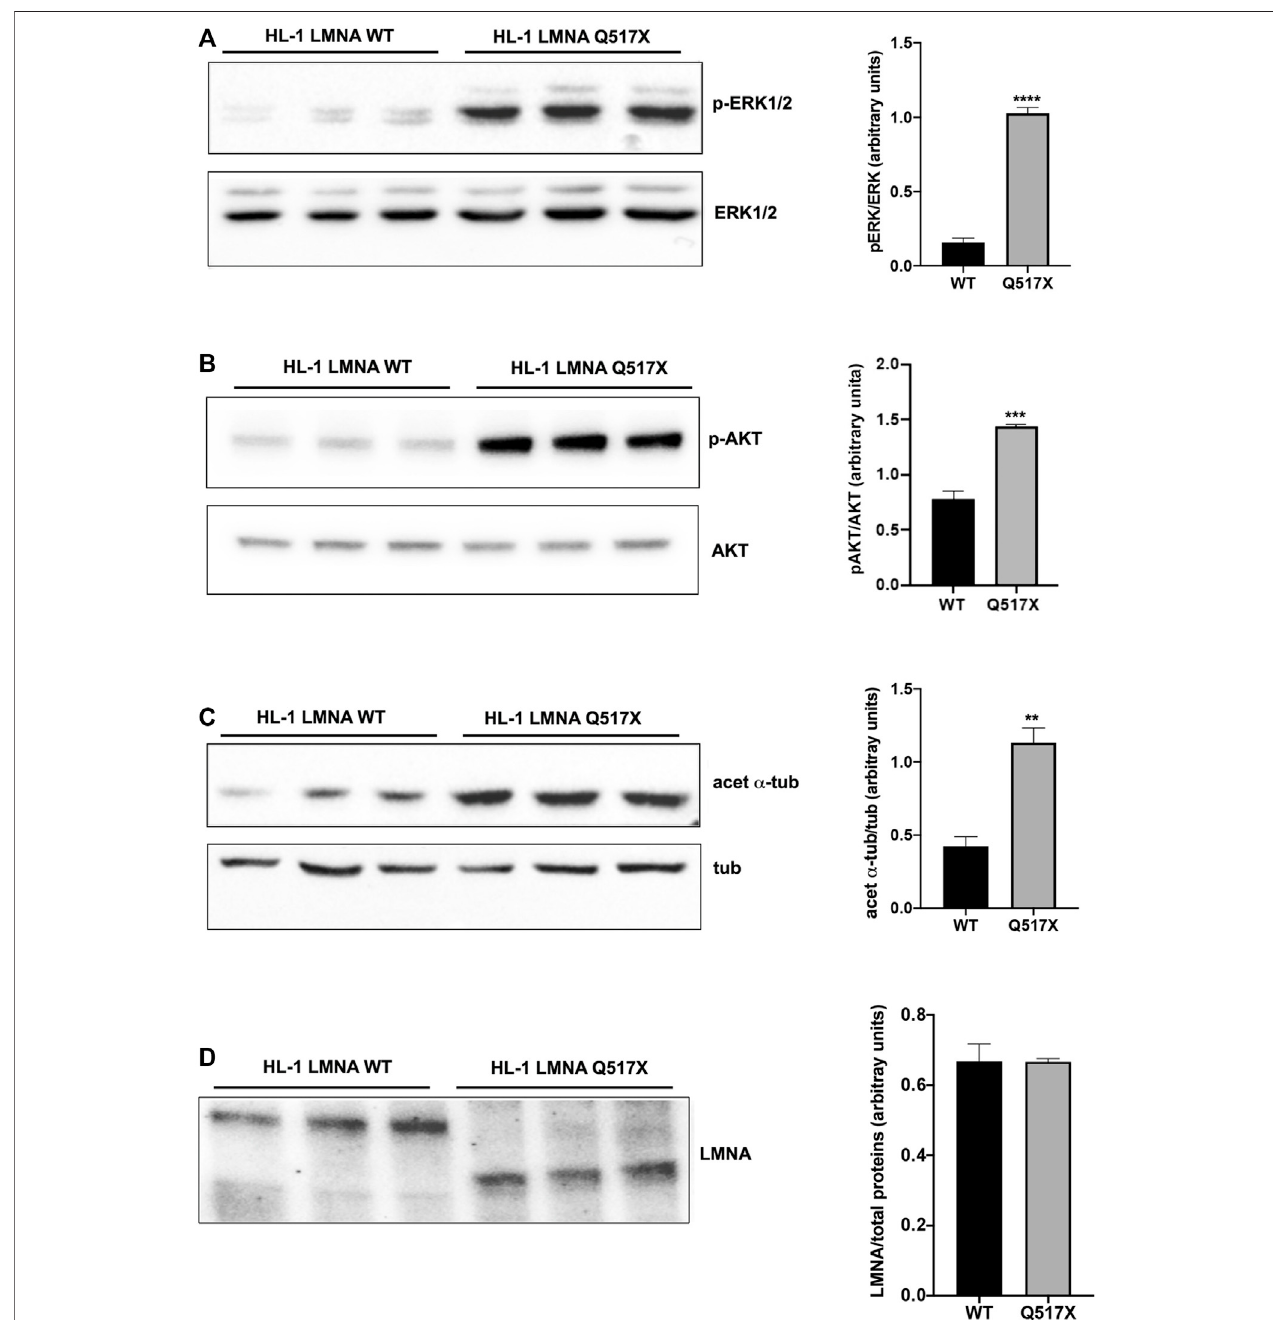
FIGURE 3 | (A) Left panel: representative western blot of p-ERK1/2 and ERK1/2 in lysates from LMNA WT and LMNA Q517X-expressing HL-1 cells; right panel: normalized densitometric analysis of p-ERK1/2 immunoreactive bands in LMNA WT and Q517X-expressing HL-1 cells. (B) Left panel: representative western blot of p-AKT and AKT in lysates from LMNA WT and LMNA Q517X-expressing HL-1 cells; right panel: normalized densitometric analysis of p-AKT immunoreactive bands in LMNA WT and Q517X-expressing HL-1 cells. (C) Left panel: representative western blot of acetylated α -tubulin (acet α -tub) and α -tubulin (tub) in lysates from LMNA WT and LMNA Q517X-expressing HL-1 cells; right panel: normalized densitometric analysis of acetylated α -tubulin immunoreactive bands in LMNA WT and Q517X-expressing HL-1cells. (D) Leftpanel:representative westernblotofmCherry-tagged LMNAinlysates fromLMNAWT andLMNA Q517X-expressingHL-1cells; right panel: normalized densitometric analysis of m-Cherry tagged LMNA immunoreactive bands. The data are means of 3 independent experiments. **** p < 0.0001 *** p < =0.001; ** p < 0.01; Student ’ s t test for unpaired data.